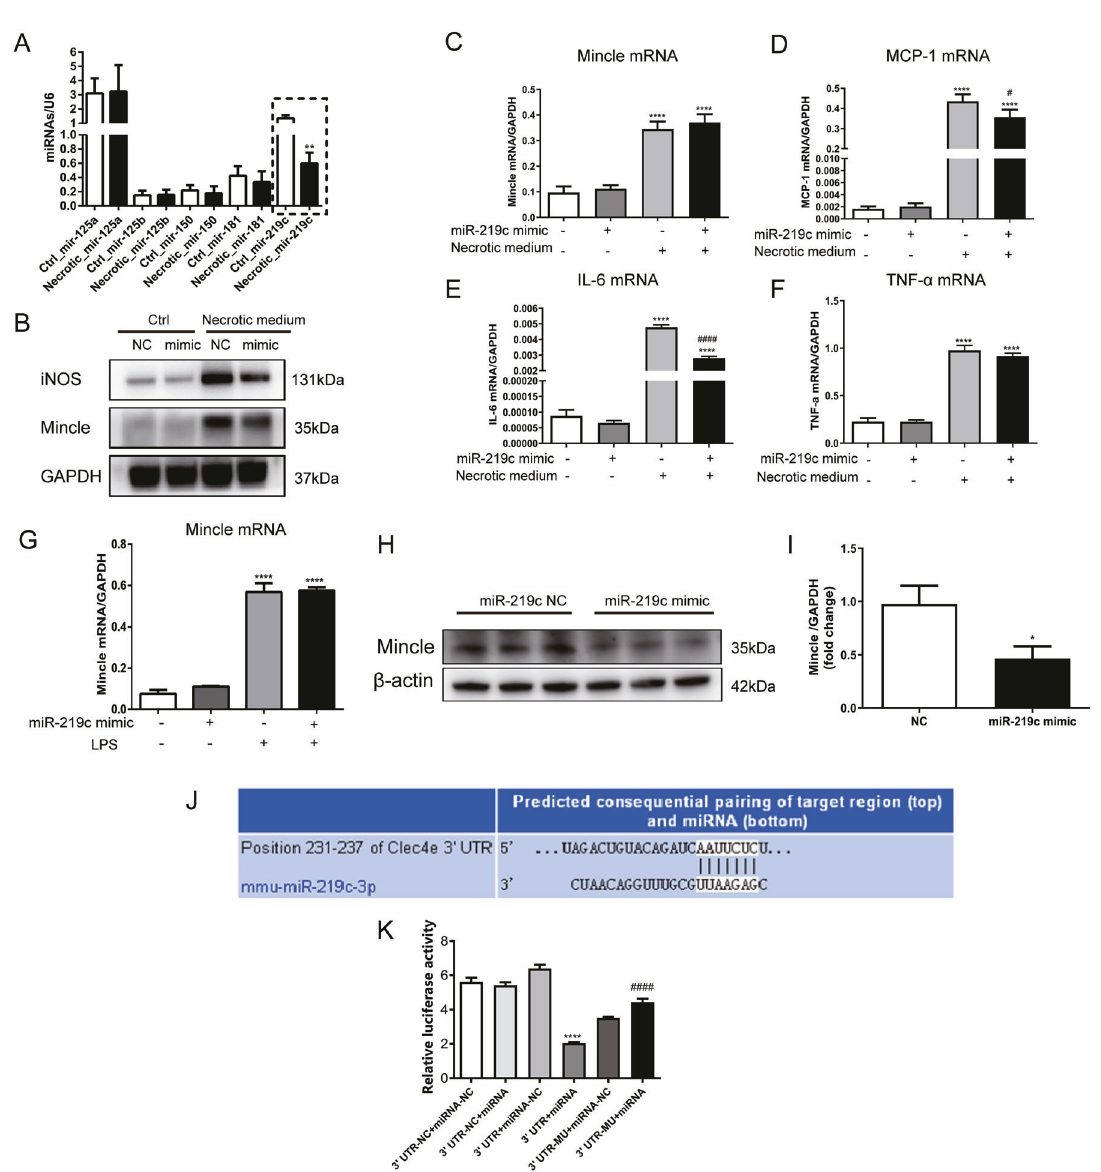
Fig. 5 Damaged tubule promoted Mincle expression and proin fl ammatory macrophage activation through miR-219c-3p. A Five miRNAs predicted to bind 3 ′ -UTR of Mincle by bioinformatics analysis were measured by RT-PCR. **p < 0.01 compared to Ctrl. B Increased expression of iNOS and Mincle protein induced by LPS were inhibited by miR-219c-3p mimic. C – F miR-219c-3p mimic transfection reversed partly the upregulation of in fl ammatory cytokine (MCP-1, IL-6) induced by the necrotic medium of TECs. **** p < 0.0001 compared to groups without treatment of necrotic medium. # p < 0.05, #### p < 0.0001 compared to cells exposed to necrotic medium with negative control of microRNA mimic. G – I Mincle translation induced by LPS was inhibited by miR-219c-3p mimic without alteration of mRNA level. **** P < 0.0001 compared to groups without LPS treatment. * p < 0.05 compared to NC. J – K Dual-luciferase reporter gene assay found that Mincle translation was inhibited by miR-219c-3p through binding to the 3 ′ -UTR of Mincle. **** p < 0.0001 compared to 3 ′ UTR-NC + miRNA, #### p < 0.0001 compared to 3 ′ UTR + miRNA. Data were presented as mean ± SD. Ctrl Control, NC negative controls, LPS lipopolysaccharide.